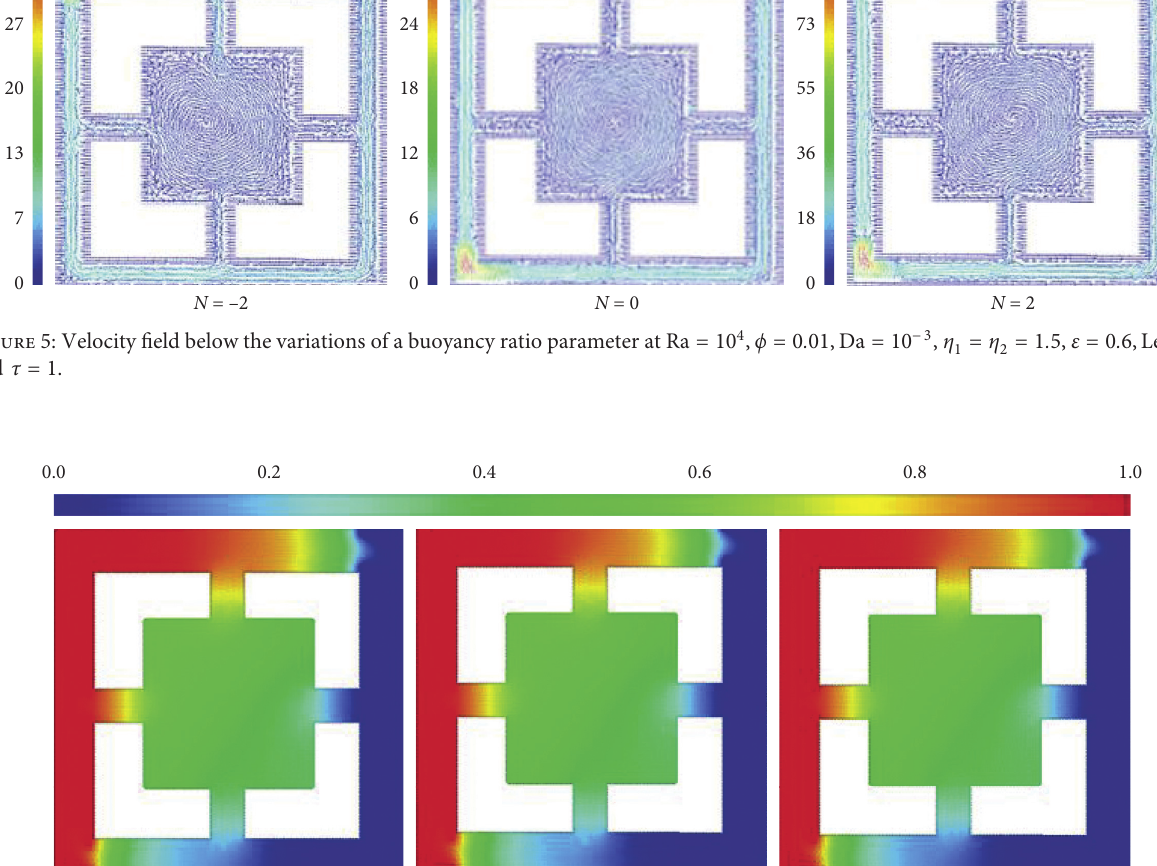
� η � 1 . 5, ε � 0 . 6 , Le � 20, 1 2